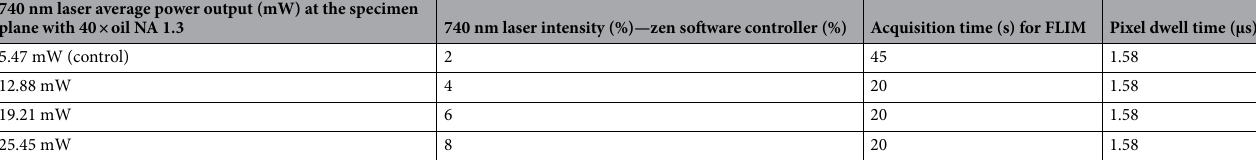
Table 1. Conditions used for FLIM Imaging in this